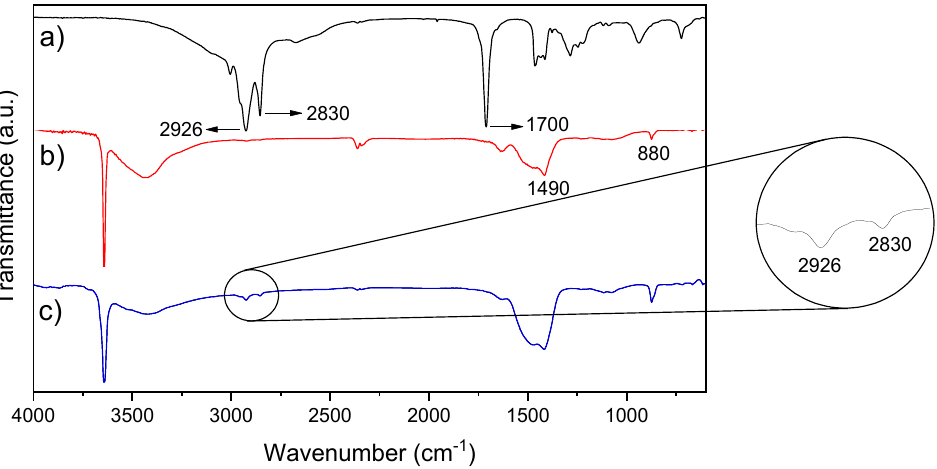
Figure 2. XRD analysis of CaO nanoparticles. Figure 3. FTIR spectra of ( a ) oleic acid, ( b ) CaO nanoparticles, and ( c ) modified CaO nanoparticles.